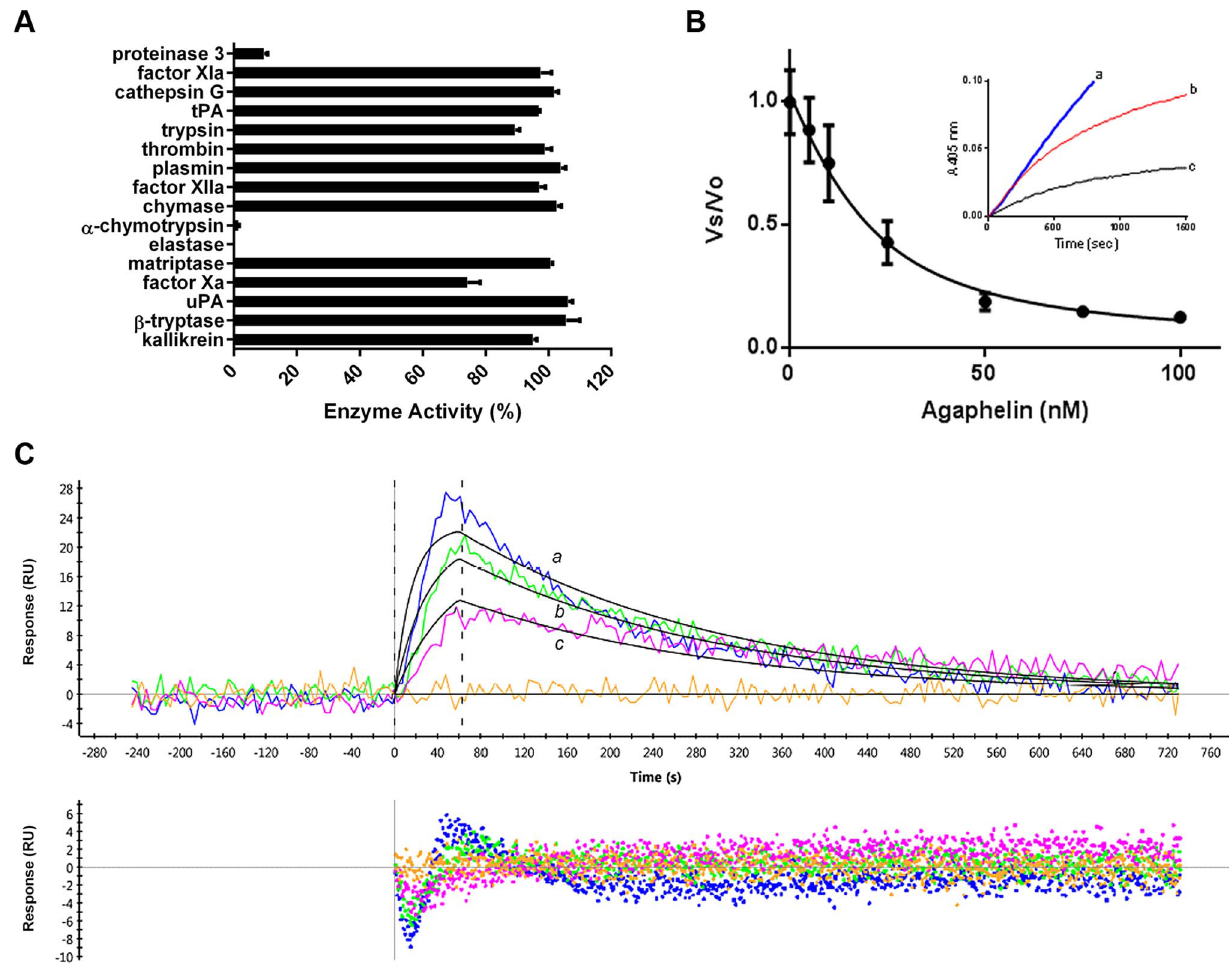
Figure 2. Agaphelin inhibits elastase. A) Agaphelin (1 m M) was tested against 16 different serine proteases in triplicates. Enzyme concentrations are provided in Material and Methods, (*, t -test; p # 0.05). B) Agaphelin inhibits elastase. Tight-type inhibitor: Elastase (18 nM) was incubated with Agaphelin (0–100 nM) for 30 min at RT followed by addition of chromogenic substrate MeOSuc-AAPV-pNA (600 m M). Residual activity was plotted as Vo (final velocity)/ Vs (initial velocity). Inset : slow-type inhibitor: elastase (18 nM) was added to a mixture containing chromogenic substrate (600 m M) and Agaphelin ( a , 0 nM; b , 150 nM, and c , 500 nM). C) Surface plasmon resonance experiments. Upper panel: Agaphelin was immobilized in a GLC chip and elastase was injected for 60 sec at 100 nM ( a , blue), 50 nM ( b , green), and 25 nM ( c , pink). Dissociation of the Agaphelin-elastase complex was monitored for 600 sec. Representative sensograms (upper panel) are shown in black lines, and global fitting of the data points using the Langmuir equation is depicted. Lower panel: residual